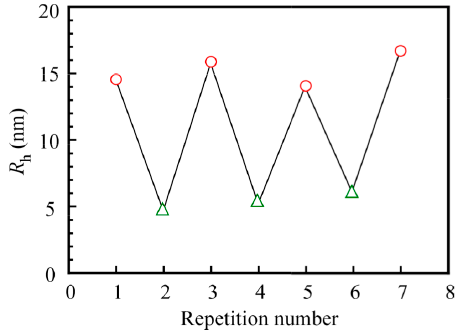
Figure 10. The hydrodynamic radius ( R h ) of the PNaSS 58 – b –PAA 125 /PNaSS 58 – b –PNIPAM 115 complex at C p = 4.4 g/L in 0.1 M NaCl at pH 3 ( ) and pH 10 ( ).